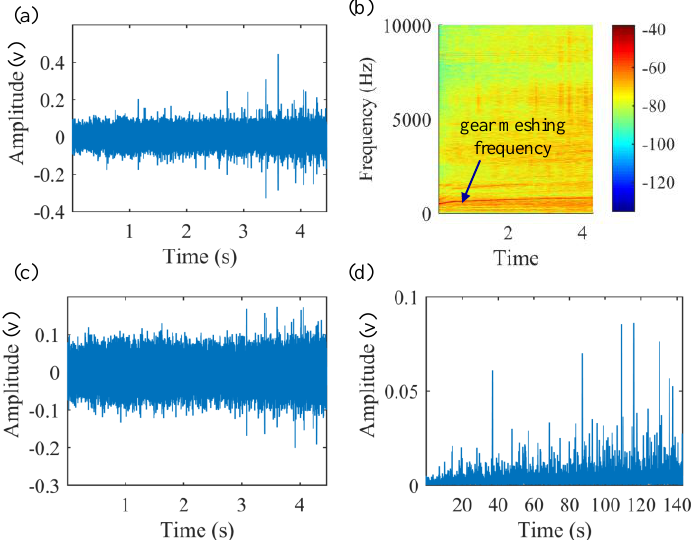
Figure 7. Outer race fault case: ( a ) Raw vibration signal, ( b ) TFR of the raw vibration signal, ( c ) lower frequency band signal, and ( d ) envelope of the resonant frequency band signal.